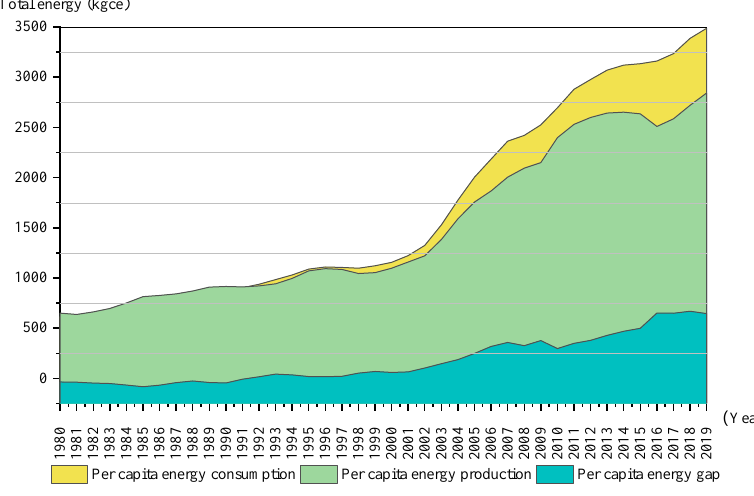
Figure 1. China’s per capita energy gap from 1980 to 2019.